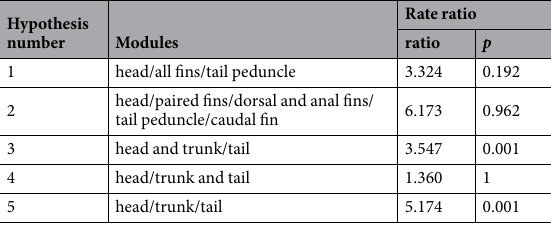
Table 2. Results of the evolutionary rate ratios.